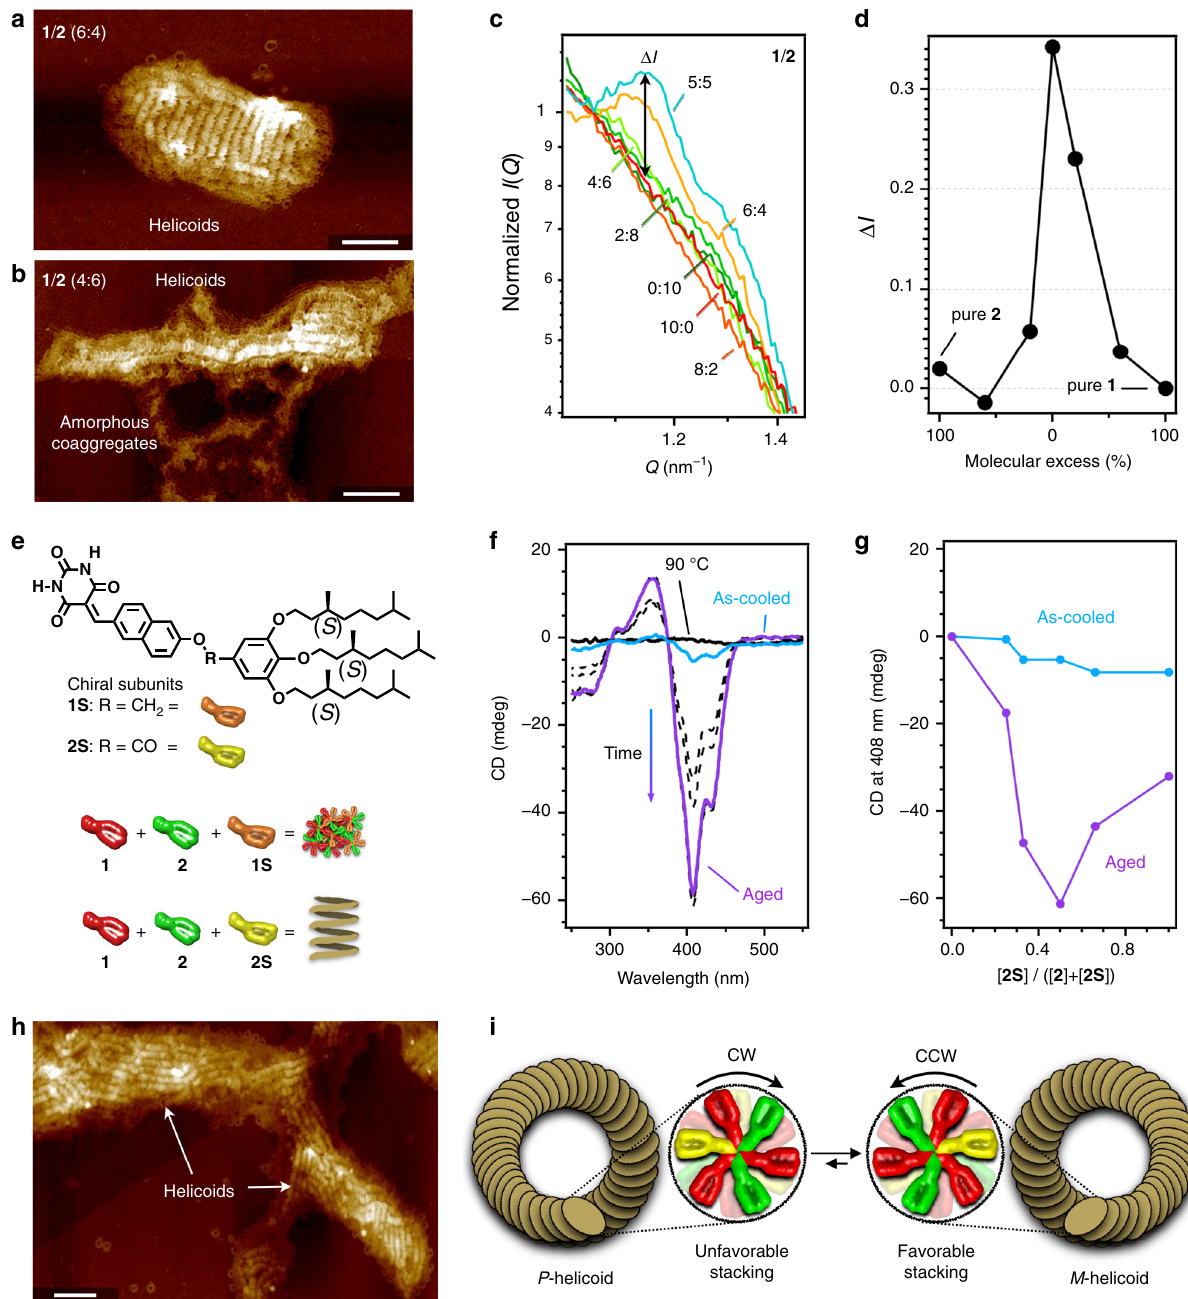
Fig. 5 Distinct contributions of the different monomers. a , b AFM images of 1 / 2 (6:4; a ) and 1 / 2 (4:6; b ) at c t = 100 µ M. The samples were prepared by spin-coating onto a HOPG substrate after 3 days of aging. Scale bars, 100 nm. c Normalized SAXS pro fi les at Q = 1.06 nm − 1 of mixtures of various ratios of 1 and 2 . Ratios: 1 / 2 (10:0; red), (8:2; dark orange), (6:4; orange), (5:5; blue), (4:6; light green), (2:8; green), and (0:10; dark green). d Plots of Δ I estimated from SAXS pro fi les as a function of the molecular excess. e Molecular structures of 1S and 2S as well as schematic representations of their tertiary mixtures. f CD spectra of 1 / 2 / 2S (2:1:1; c t = 500 µ M) measured at 90 °C (black), immediately after cooling (blue), and after 9 days of aging (purple). g Plots of the intensity of the CD spectra at 408 nm immediately after cooling (blue) and after aging until reaching equilibrium (purple) as a function of the ratio of 2S relative to the total amount of 2 derivatives; the concentration of 1 (250 µ M) and the c t (500 µ M) were kept constant. h AFM image of the helicoids of 1 / 2 / 2S (2:1:1; c t = 500 µ M) after 7 days of aging. Scale bar, 100 nm. i Proposed mechanism for the elongation of the unidirectional helicoidal fi